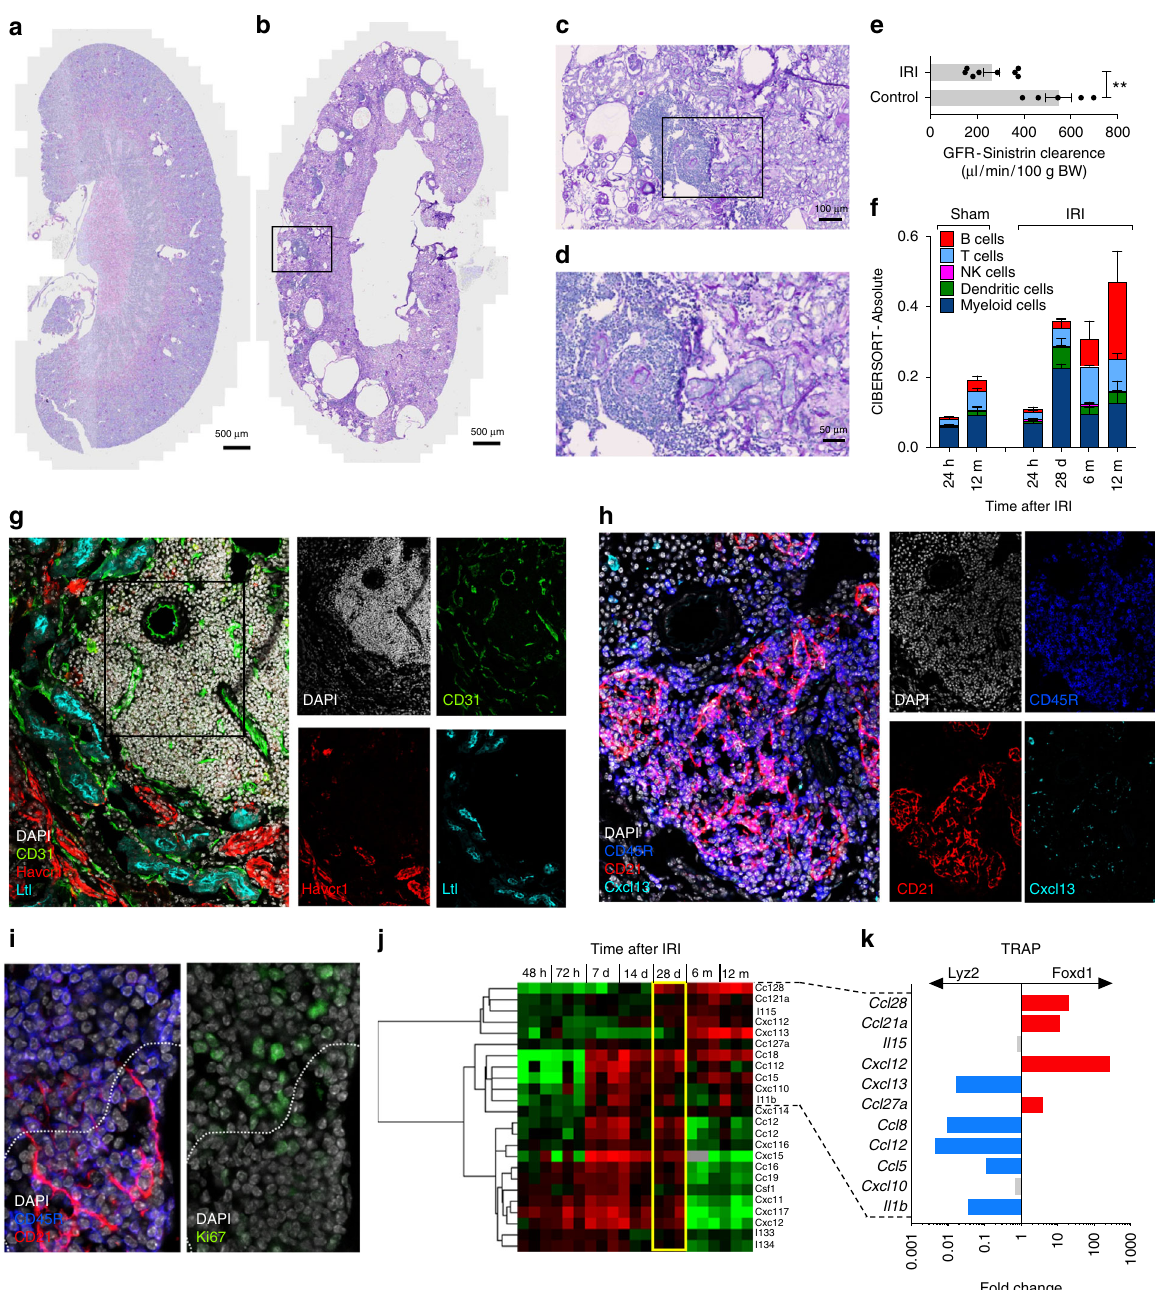
Fig. 3 Tertiary lymphoid organs in the mouse kidney after ischemia/reperfusion injury. a – d Periodic acid-Schiff (PAS) staining of representative mouse kidney sections 16 months after IRI ( b – d ) or age-matched controls ( a ); n = 3/group; scale bar = 500 μ m in ( a , b ), 100 μ m in ( c ), and 50 μ m in ( d ). e Glomerular fi ltration rate (GFR), as measured by sinistrin clearance, in 7 mice 16 – 18 months after IRI and in 5 age-matched controls. Mann – Whitney test, ** P < 0.01. f Semi-quantitative evaluation of immune cell in fi ltrates in the kidney at different time points after IRI or sham surgery as determined by CIBERSORT analysis on whole kidney RNAseq data. Mean values and SE are shown, n = 3/group. g , h Immunostaining of consecutive sections obtained from a representative mouse kidney 6 months after IRI ( n = 3 – 4/group). CD31: endothelial cells; Havcr1 (Kim1): marker of tubular injury; Ltl: proximal tubule. CD45R: B cells (and a subset of T cells, s. Supplementary Fig. 2); CD21 and Cxcl13: follicular dendritic cells. i Higher magni fi cation of the B cell zone highlighting the partial separation of germinal centers in two areas: upper part with Ki67 + proliferating cells, lower part with CD21 + follicular dendritic cells. j Cluster analysis of cytokine transcripts obtained from RNAseq data from renal tissue at different time points after IRI ( n = 3 for each time point). k Cell speci fi c expression analysis of cytokine transcripts from RNAseq data obtained after TRAP from Foxd1-derived renal stroma cells and Lyz2-derived myeloid cells at 28 days after IRI. The ratio of the mean RPKM values (Foxd1/Lyz2) obtained from 3 independent mice, including cytokine genes involved in the late immune response according to panel ( j ) are shown. Genes speci fi cally expressed in myeloid cells are shown in blue and in stroma cells in